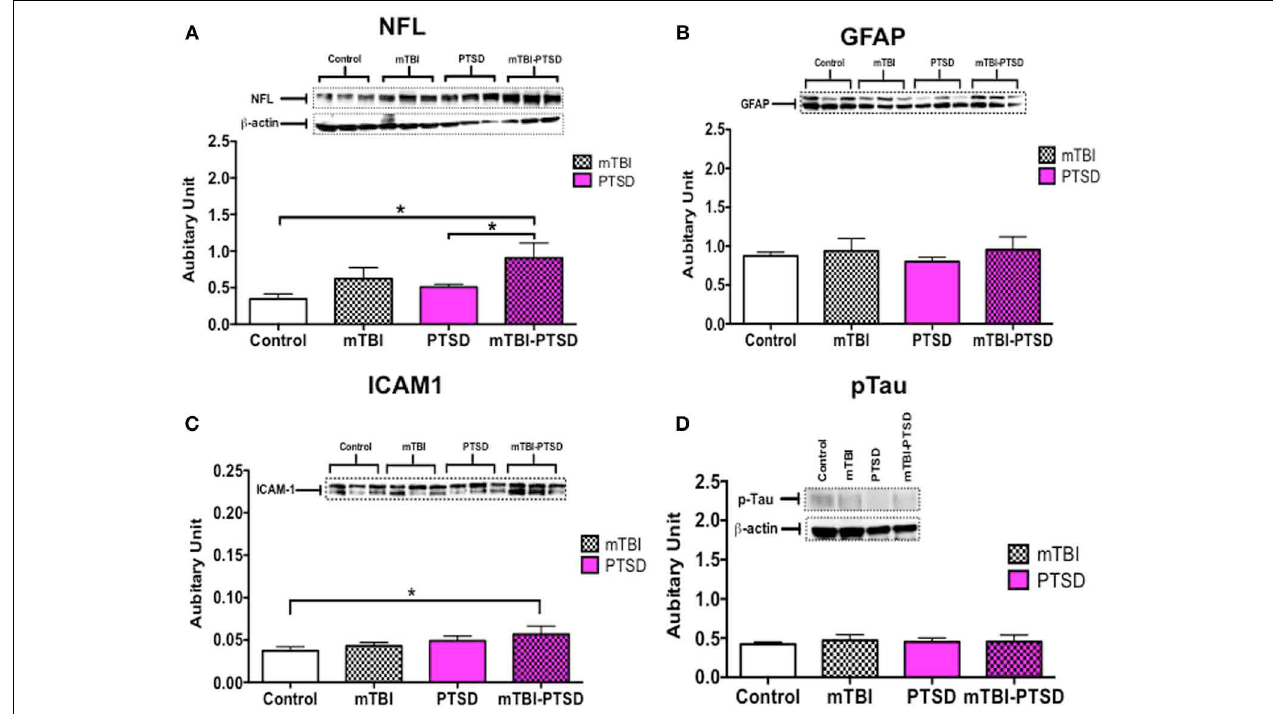
and phospho-tau protein (detected by s202 antibody—CP13) in all groups analyzed (B,D) . Data are presented as mean ± SEM. Arbitrary units were calculated by normalizing with beta-actin levels [beta-actin blot depicted in (A) , was used to calculate GFAP and ICAM-1 arbitrary values]. Data were analyzed with Kruskal Wallis-One-Way ANOVA followed by Dunn’s correction for multiple testing. Asterisk denotes statistical significance as follows: ∗ P < 0 . 05. ( N = 4–5).